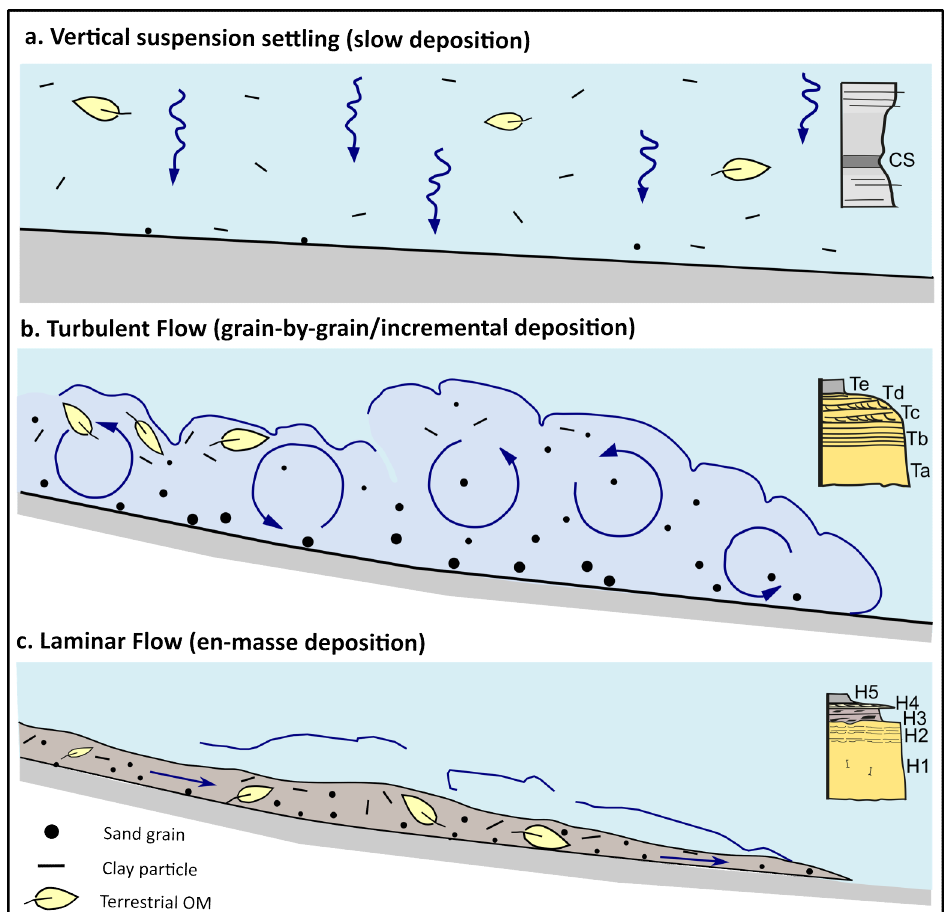
Figure 5. Conceptual models accounting for three dominant mechanisms responsible for OM deposition and segregation in the deep sea. ( a ) In bed capping (Te or H5 divisions) and background mudstones OM is accumulated from slowly settling suspensions and these flows are prone to higher OM oxidation and degradation. CS= condensed section; ( b ) turbidity currents where grain-by-grain deposition takes place, OM is often segregated towards the tops and/or tail regions of the flows (namely Td and Te divisions), although some OM could be deposited as bed load in Ta-Tc parts; and ( c ) hybrid event beds OM is also locked in lower tiers (below H5 divisions, which are equivalent to Te mud caps in turbidites), particularly in H3 divisions emplaced by turbulence-dampened laminar flows, thereby providing higher post-burial protection.